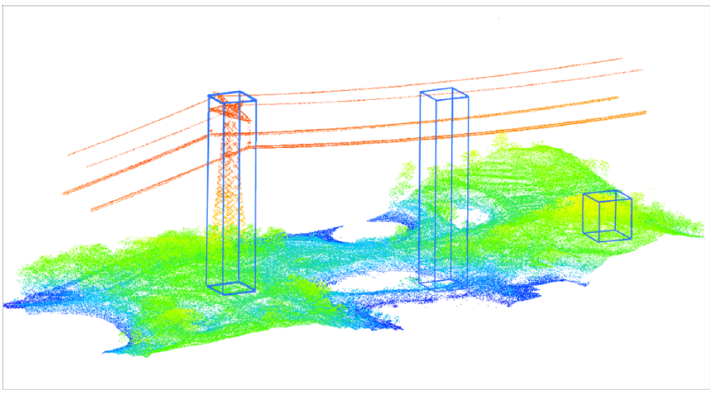
Figure 2. Cells of pylon, power line and ground